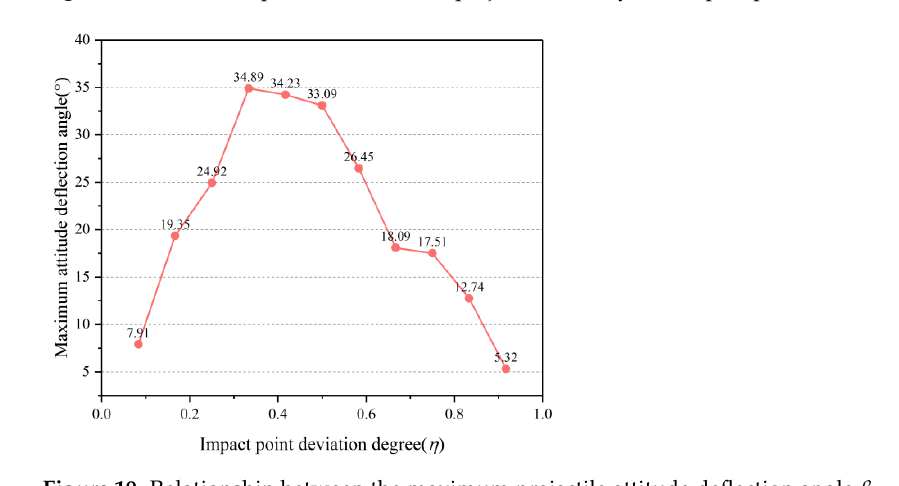
Figure 18. Relationship between residual projectile velocity and impact point deviation degree η .